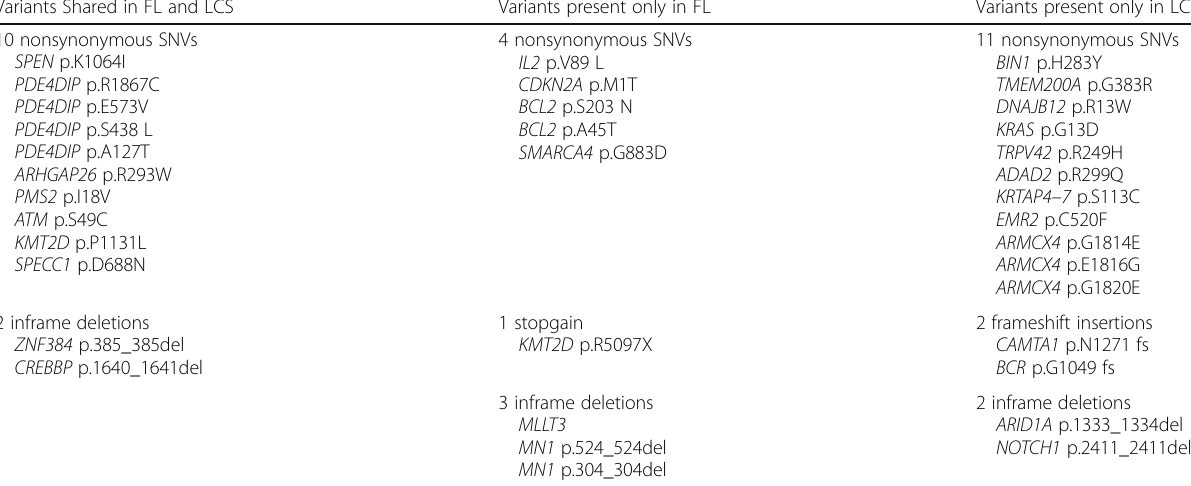
Table 2 Summary of Variants with Possible or Unknown Significance Present in Follicular Lymphoma or/and Langerhans Cell Sarcoma Variants Shared in FL and LCS Variants present only in FL Variants present only in